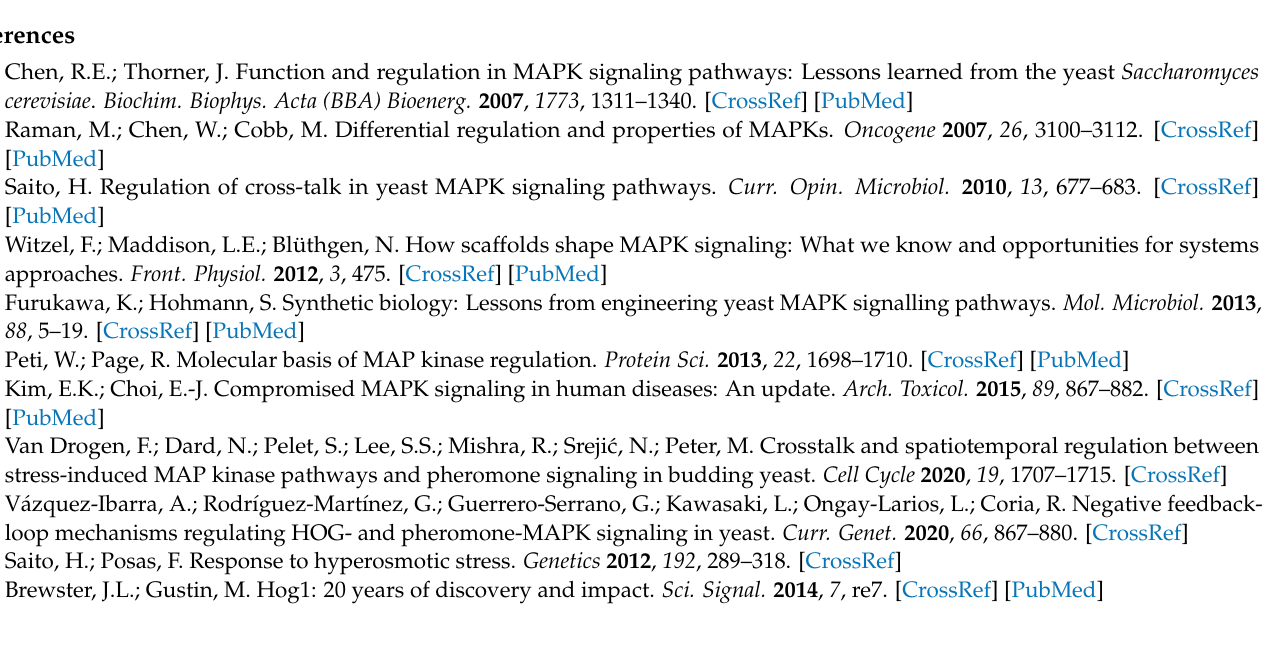
Figure S3, Sequence alignment of Rga1 and Rga2; Figure S4, Mating pathway activation during Hog1-as inhibition under isosmotic conditions in rga1 ∆ and bud14 ∆ mutants; Figure S5, Fluorescence microscopy-based analysis of reporter gene expression in rga1-505 and bud14 ∆ single mutants and in a rga1-505 bud14 ∆ double mutant and in rga1 ∆ and rga2 ∆ single mutants and in a rga1 ∆ rga2 ∆ double mutant; Figure S6, Analysis of the kinetics and dose dependence of Fus3 and Hog1 activation; Figure S7, Analysis of the response of rga1-505 mutant cells to simultaneous stimulation by increasing concentrations of sorbitol and α -factor; Figure S8, Effect of Rga1 over-expression on reporter gene expression and crosstalk; Figure S9, Analysis of Hog1-mediated Rga1 phosphorylation in vitro and of Rga1 phosphorylation in